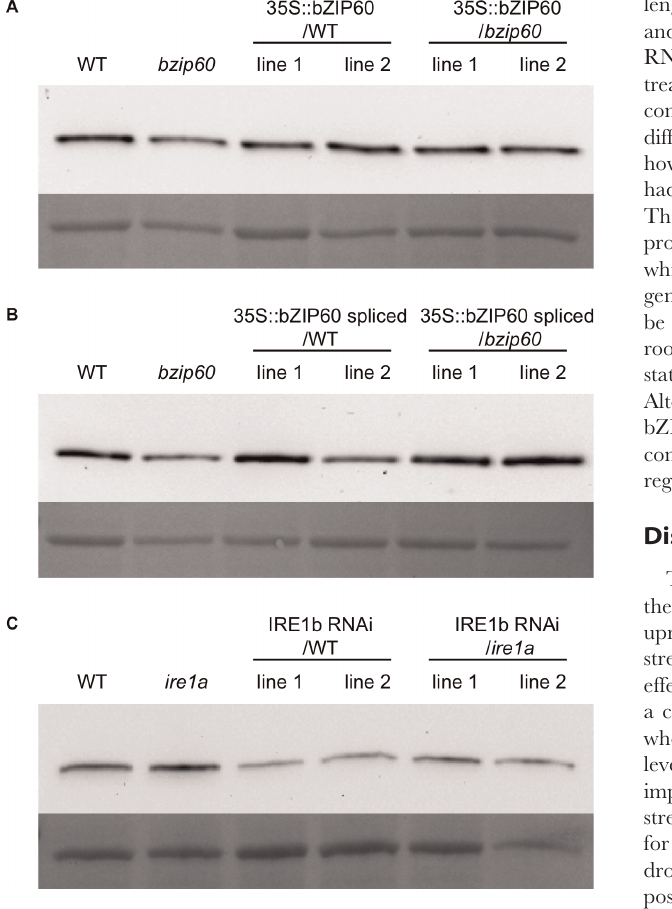
Figure 4. BiP protein accumulation in transgenic and mutant lines altering the bZIP60/IRE1 pathway. Western blots revealing BiP levels in total protein extracts from 8 d-old seedlings treated with 2 mM DTT for 8 h. The membrane was stained with Ponceau red and shows the large subunit of Rubisco as a loading control. A. WT, bzip60 mutant and transgenic lines over-expressing bZIP60 full-length in WT and bzip60 backgrounds. B. WT, bzip60 mutant and transgenic lines over-expressing bZIP60 spliced in WT and bzip60 backgrounds. C. WT, ire1a mutant and IRE1b RNAi lines in WT and ire1a backgrounds. Two independent lines are shown for each transformed construct.